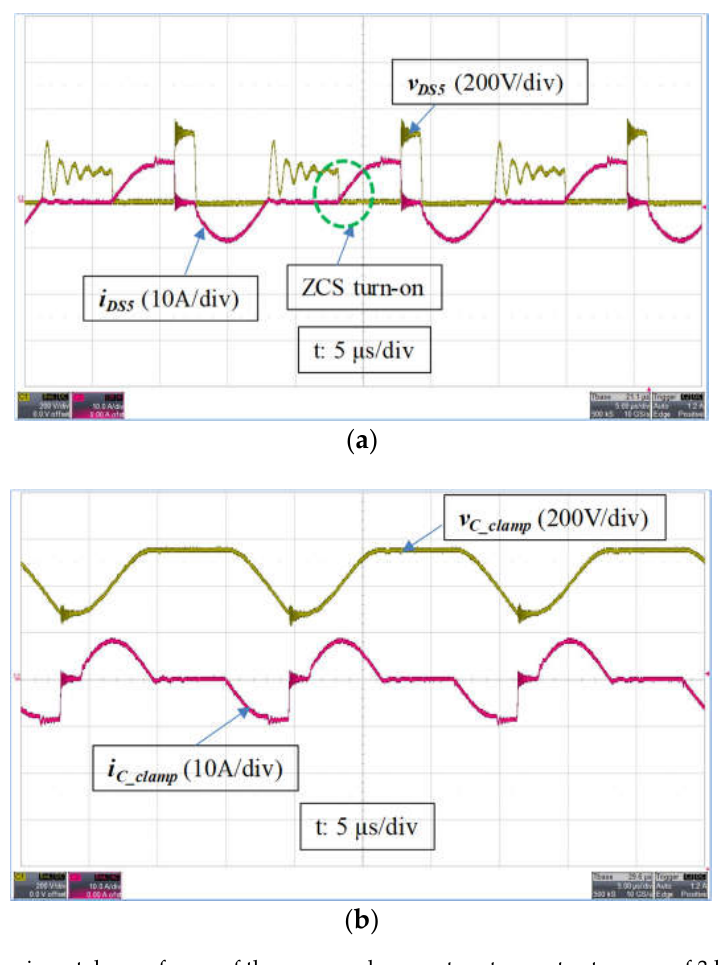
Figure 11. Experimental waveforms of the proposed converter at an output power of 3 kW. ( a ) Voltage and current waveforms of the secondary active switch, S 5 ; ( b ) voltage and current waveforms of the clamp capacitor, C clamp .